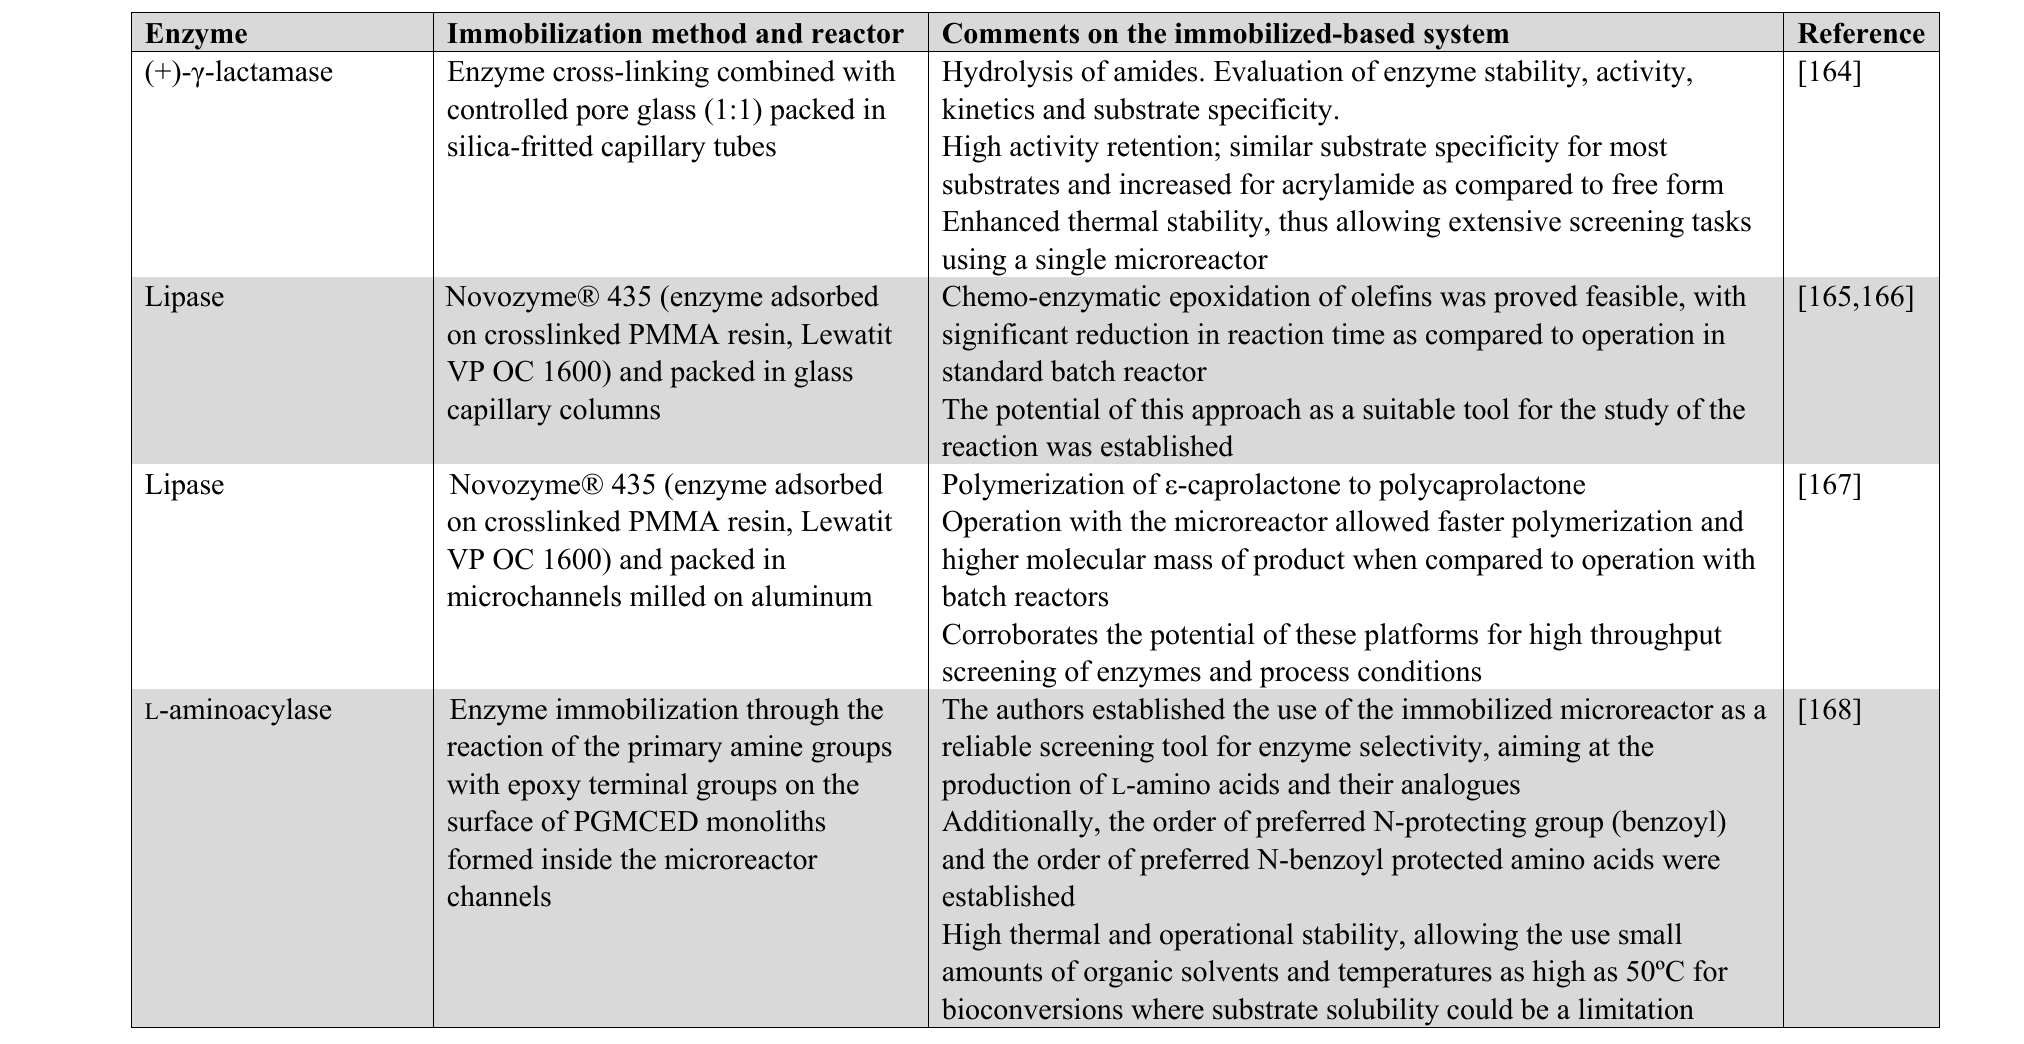
Table 2. Packed-bed type microreactors: some